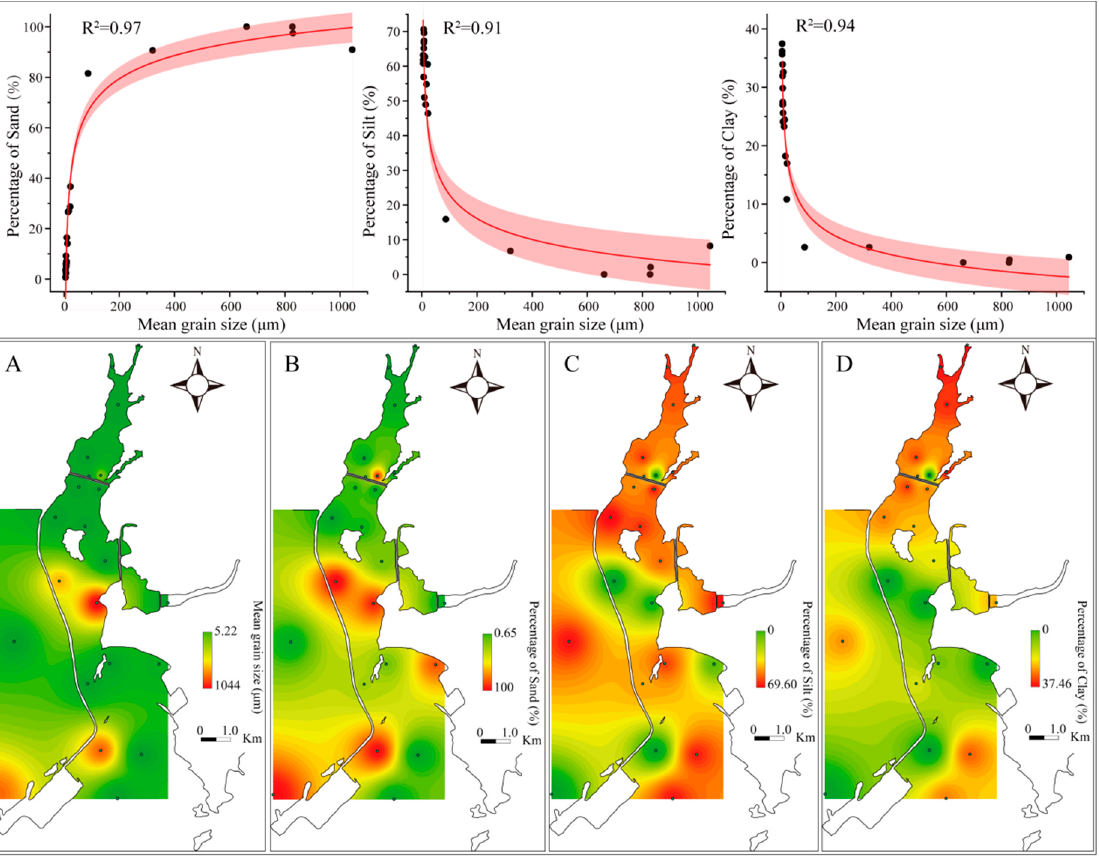
Figure 5. The correlation between mean grain sizes, sand and spatial distribution of silt and sand in the Lu’erhuan River Sea area of Qinzhou Bay, Guangxi Province. The ( A – D ) in the Figure 5 respectively shows the content distribution of mean grain sizes and percentage of sand, silt and clay.